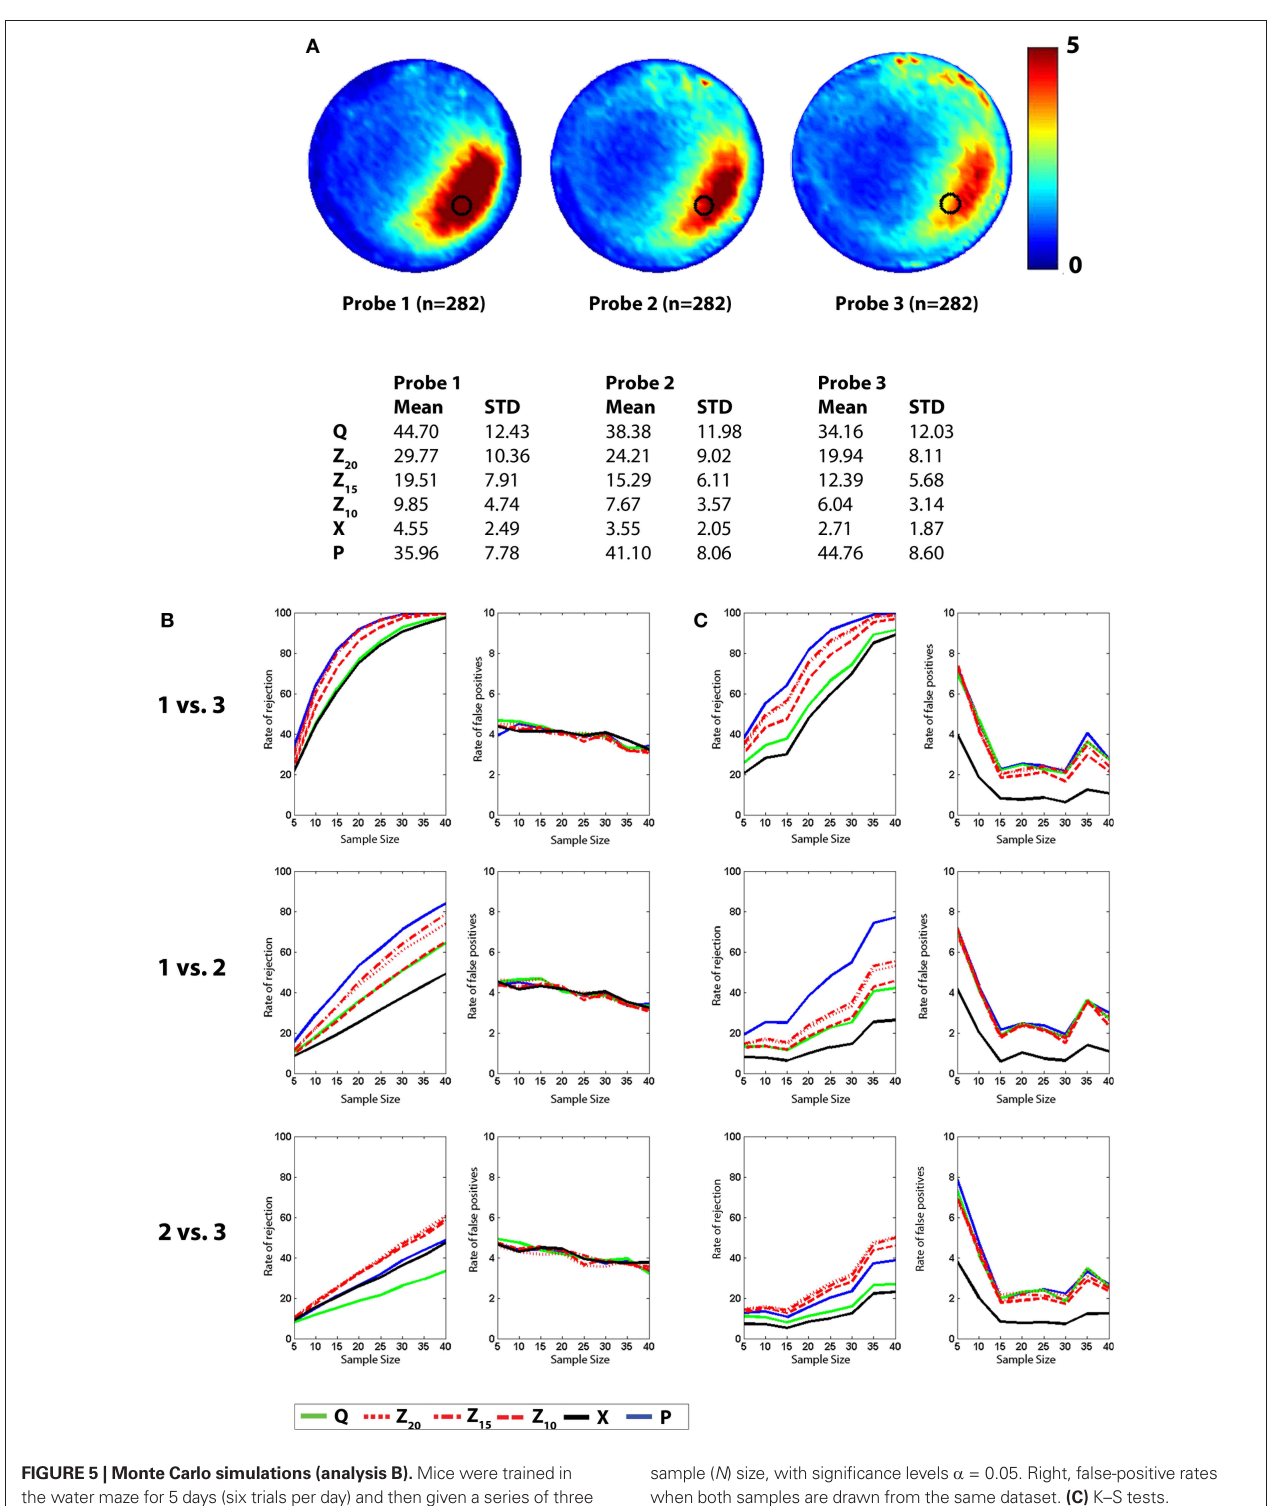
FIGURE 5 | Monte Carlo simulations (analysis B). Mice were trained in the water maze for 5 days (six trials per day) and then given a series of three probe tests. (A) Density plots for grouped data showing probes 1, 2 and 3. The color scale represents the number of visits per animal per 5 cm × 5 cm area. The table below indicates that performance declined across probe tests, according to all measures. (B) t -tests. Left, the likelihood of detecting a difference between the probe 1, 2 and 3 datasets is shown for varying